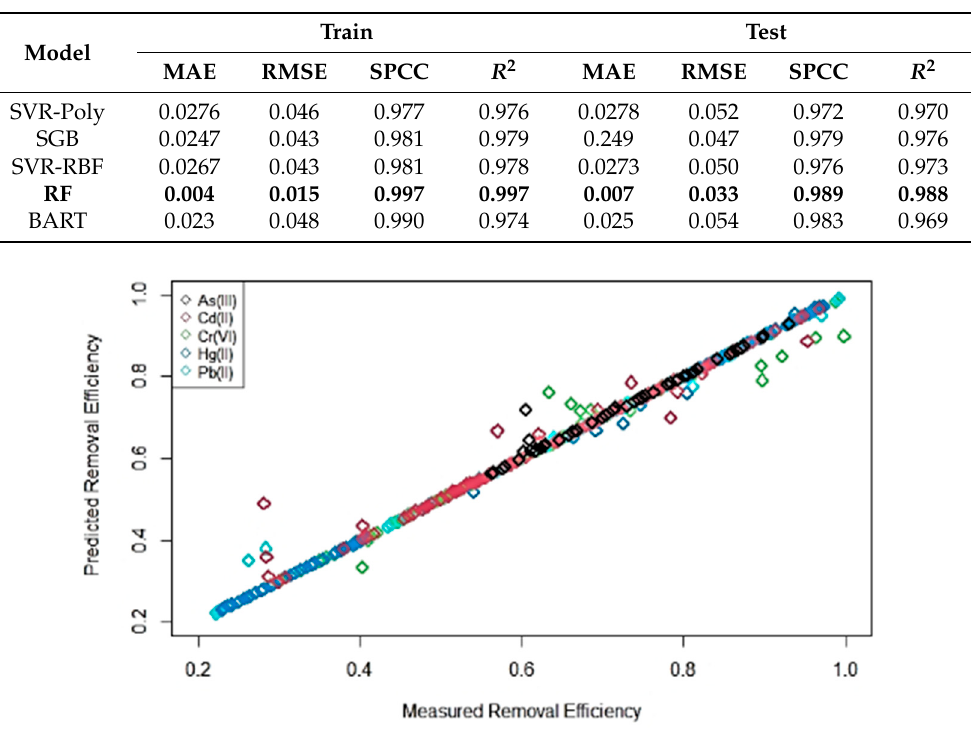
Figure 3. The predictions of removal efficiencies for the independent test data using the generalized RF model for different metals.